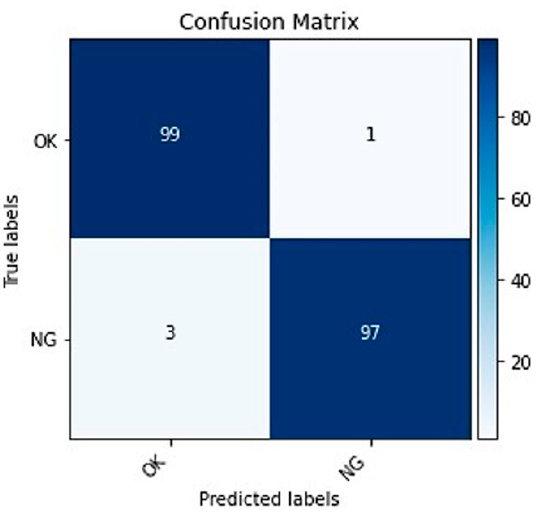
Figure 5. Confusion matrix of the proposed model for the 3D ball joint socket test dataset with 98% average accuracy score. OK and NG indicate the non-defective and defective samples, respectively. Table 4. A classification report of the proposed CNN model with SCA to demonstrate preci- sion, recall, F1-score, and accuracy results. OK and NG indicate the non-defective and defective samples,